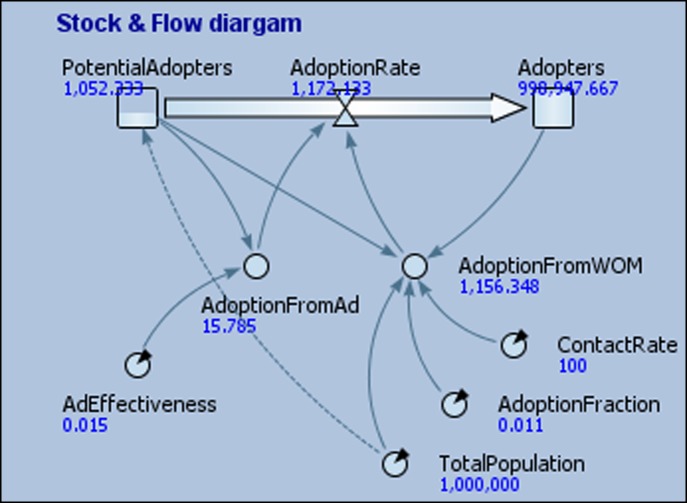
A system dynamics model for diffusion of a product (AnyLogicTM).